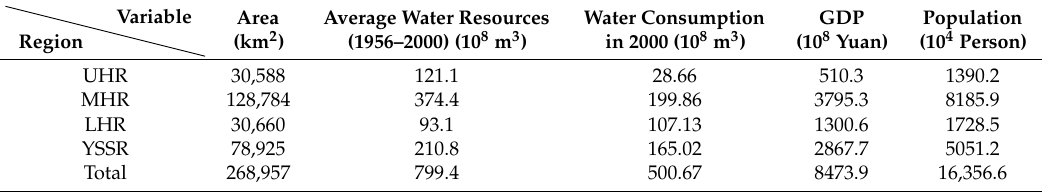
Table 1. Water quantity, water consumption, GDP, and population in the Huai River Basin.